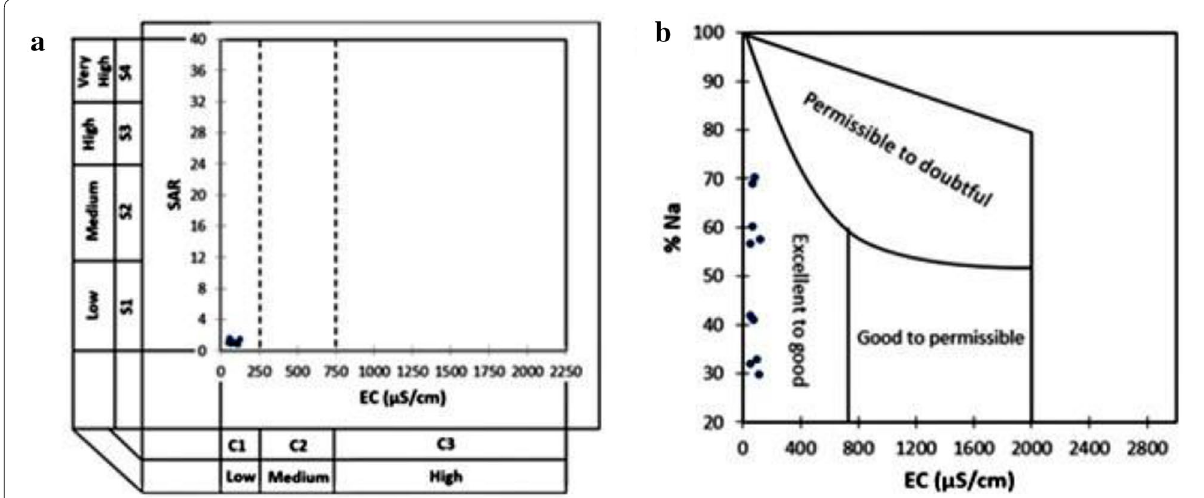
Fig. 6 Irrigation water quality assessment based on a USSL diagram and b Wilcox